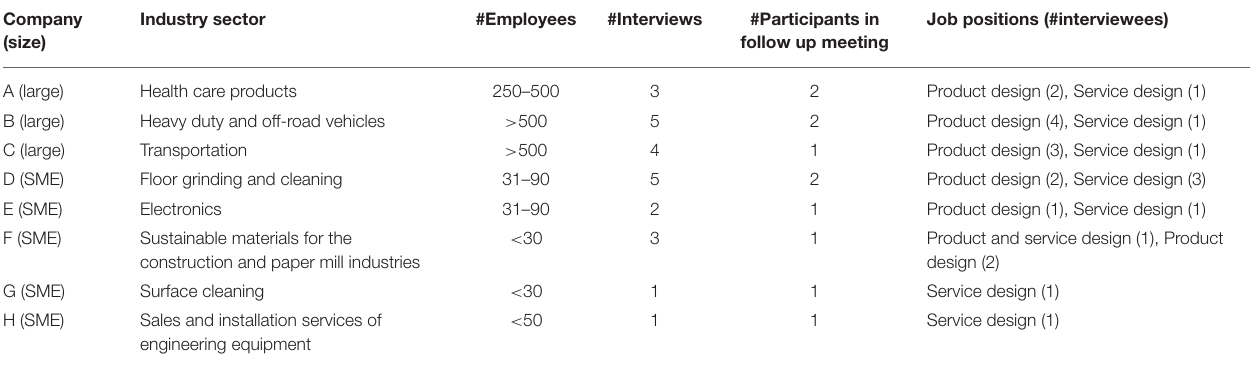
TABLE 1 | Participating companies and relevant job positions of